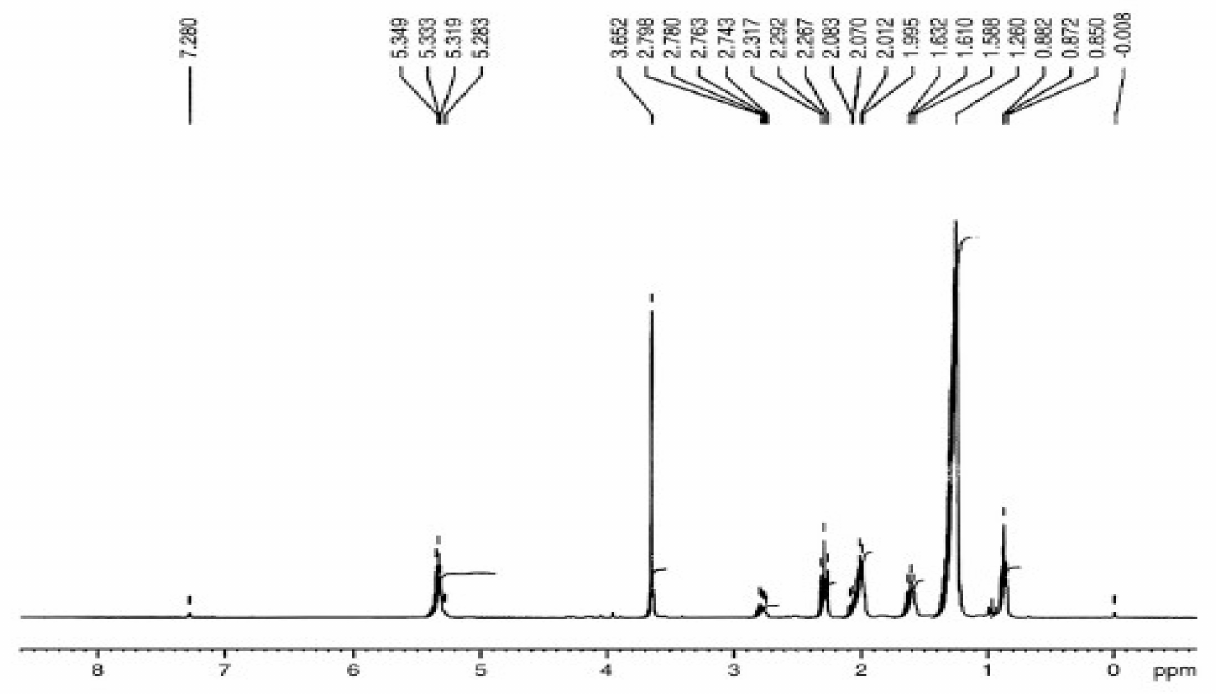
Figure 20. 1 H NMR spectrum of Prunus aitchisonii biodiesel treated with